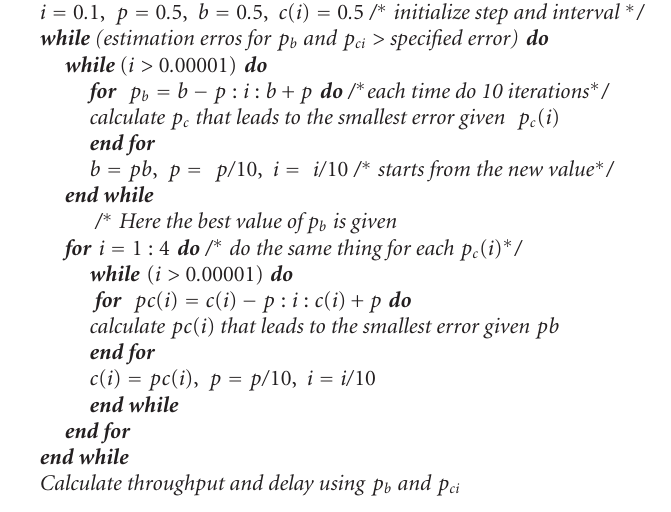
Algorithm 2: Optimized search for the